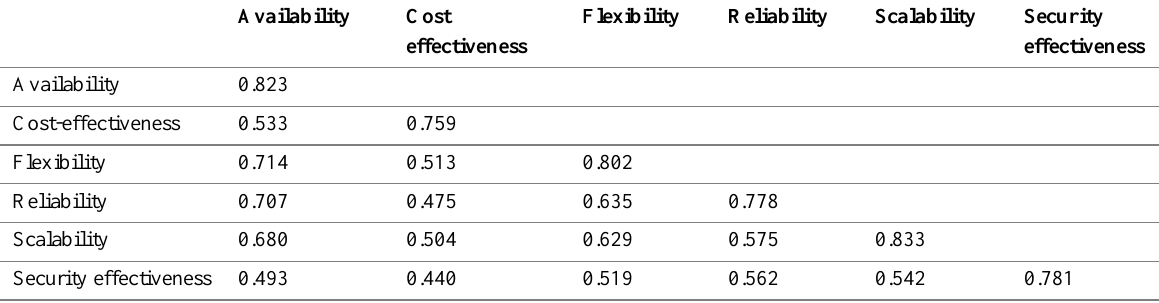
Table 4: Discriminant Validity with Fornell-Larcker